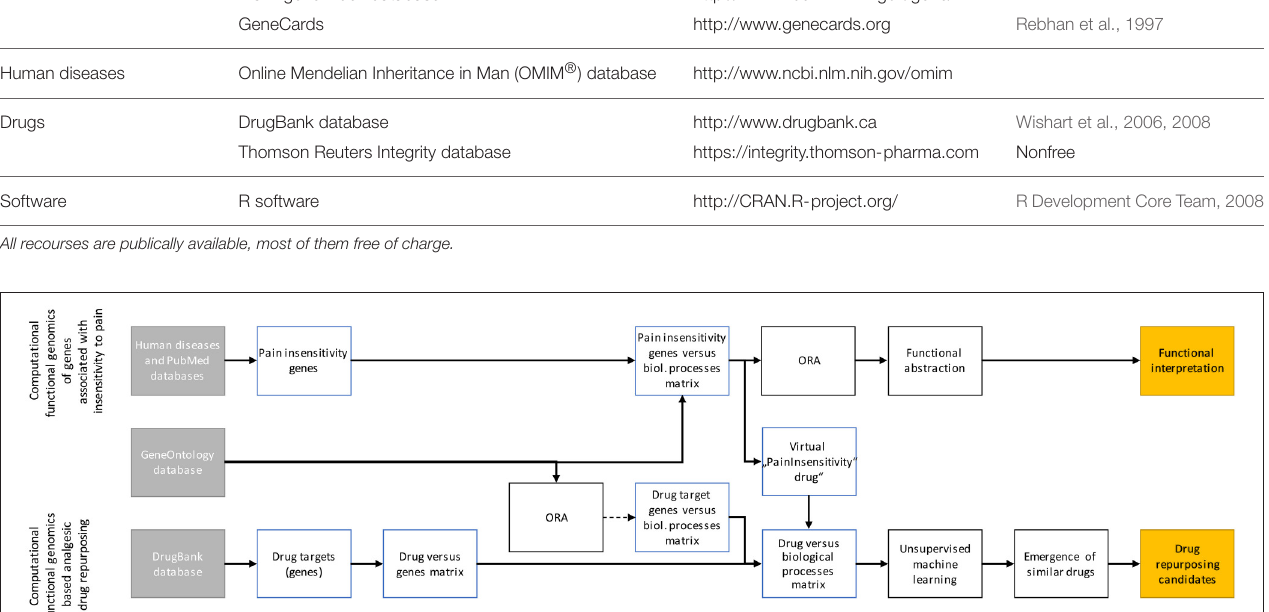
of “functional abstraction” (Ultsch and Lötsch, 2014).